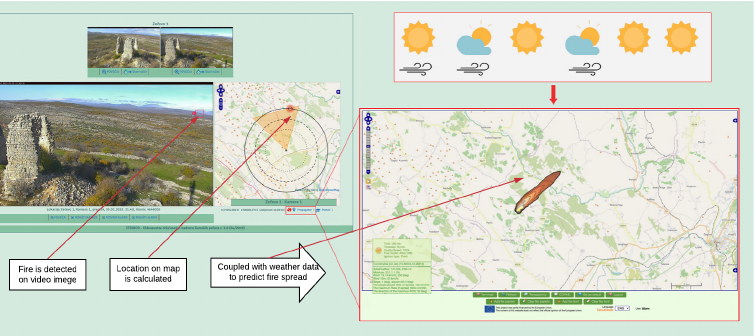
Figure 8. The exchange of information between fire detection and fire propagation